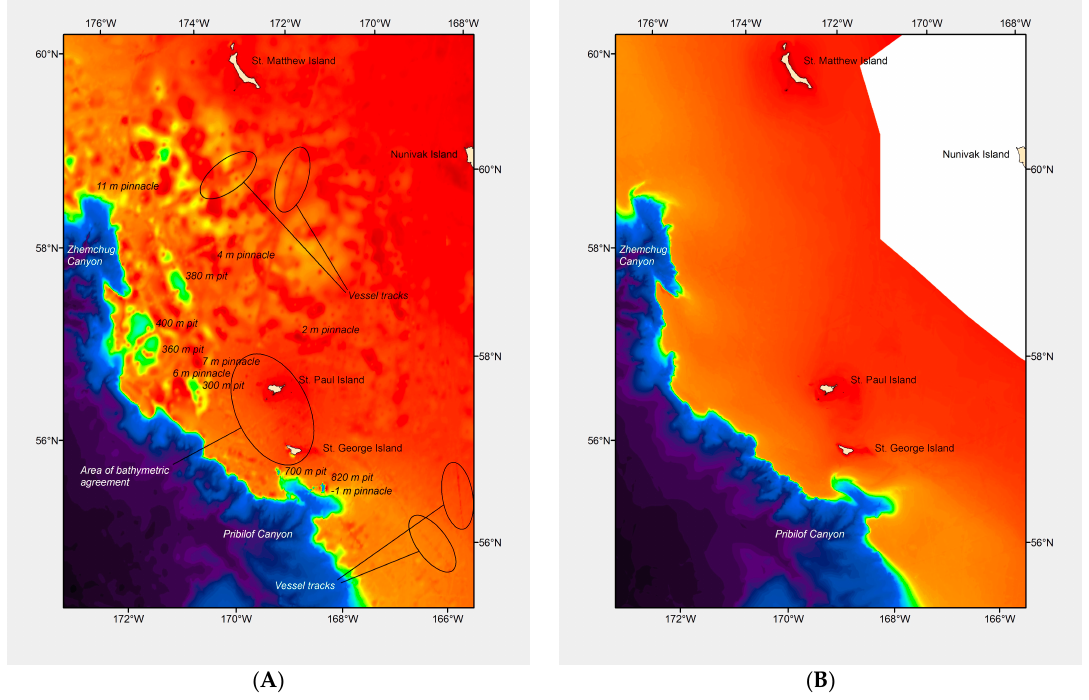
Figure 9. Comparison of eastern Bering Sea bathymetry between ( A ) the global GEBCO compilation [11] with numerous artifacts in the area between Zhemchug and Pribilof canyons and ( B ) our bathymetry which depicts a much smoother surface.